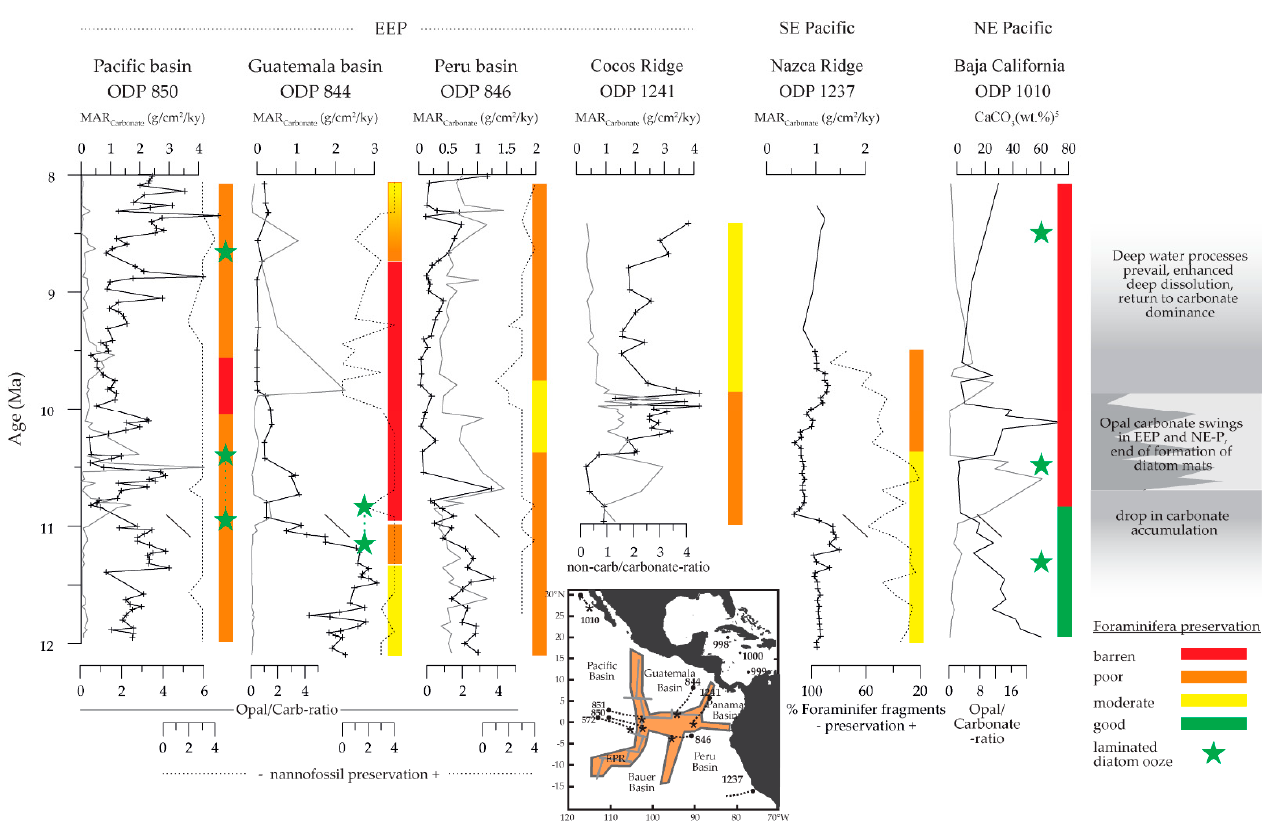
Figure 3. The phases of the Eastern Pacifc CC-events can be roughly divided into three phases. First a drop in carbonate accumulation at 11.5 to 10.8 Ma. Afterwards opal and carbonate accumulate in alternating phases (“swings”) and the deep-water signal of dissolution sets in at about 10.3 to 10.Ma. For data reference see Table 1. Color bars refer to the preservation state of planktonic foraminifera as found in the ODP Initial Site Reports.